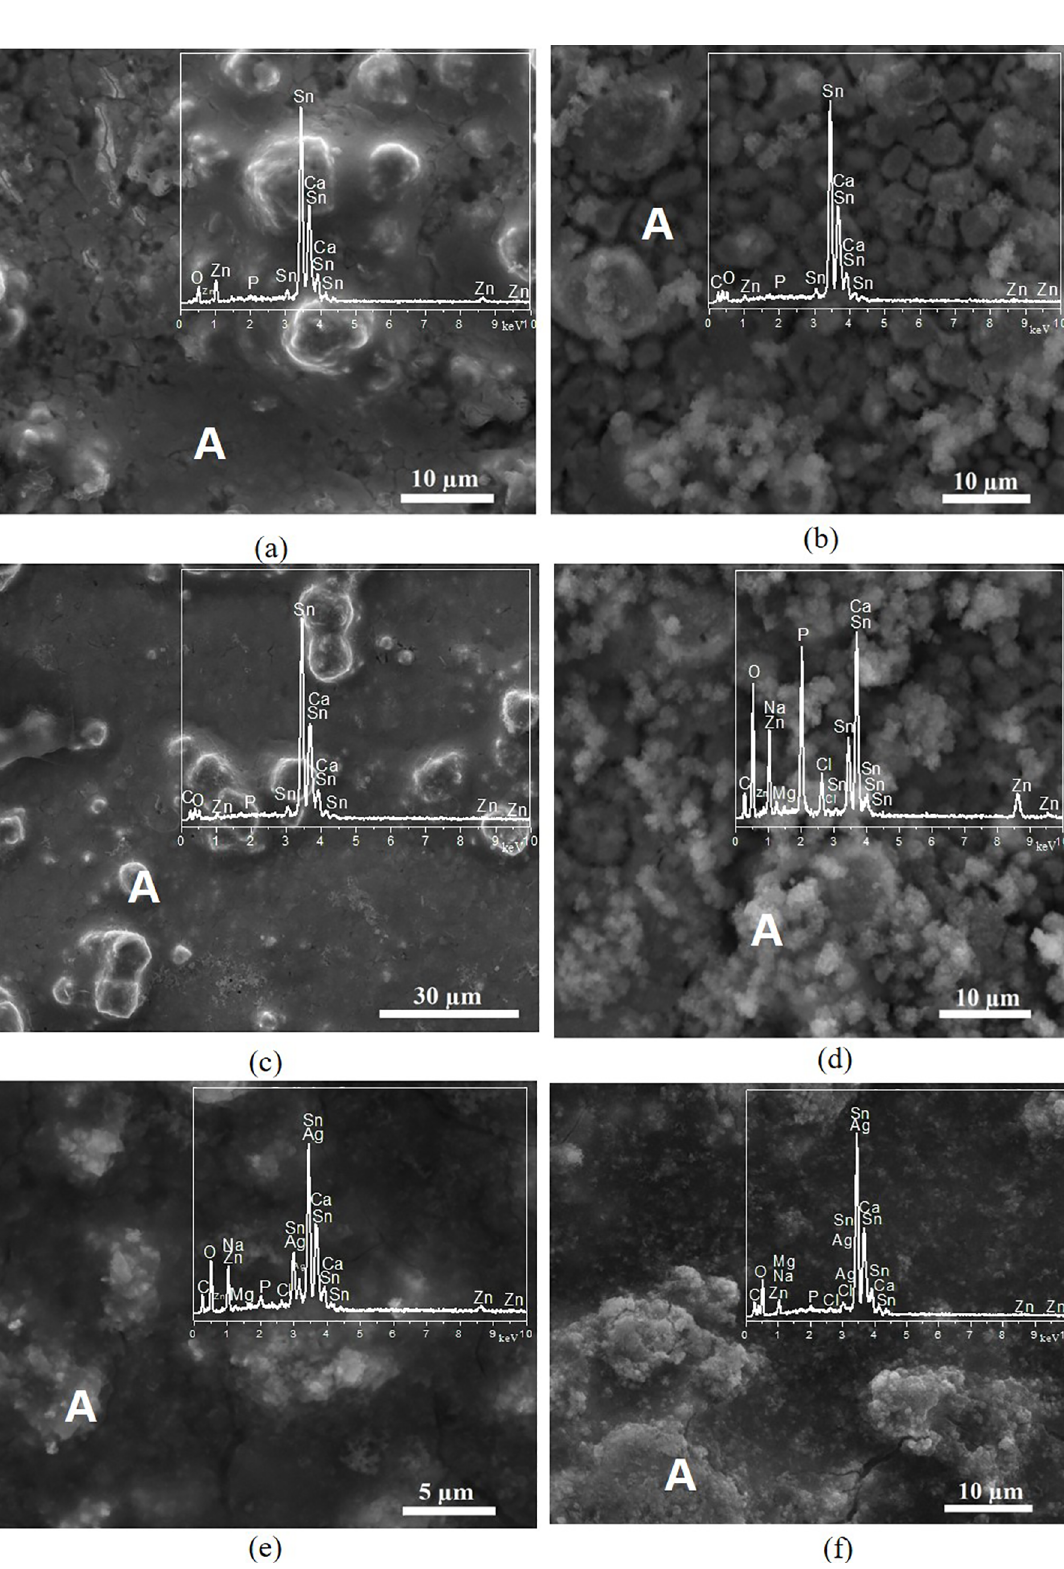
Figure 7. Micrographs obtained by SEM and EDS spectra obtained at the point A. Bioactivity essay. (a) Sn3Zn-ribbon-1ª week; (b) Sn3Zn-ribbon-4ªweek; (c) Sn3Zn+PCL ribbon-1ªweek; (d) Sn3Zn+PCL ribbon-4ªweek; (e) Sn3Zn+PCL+NPAg-ribbon-1ªweek; (f)